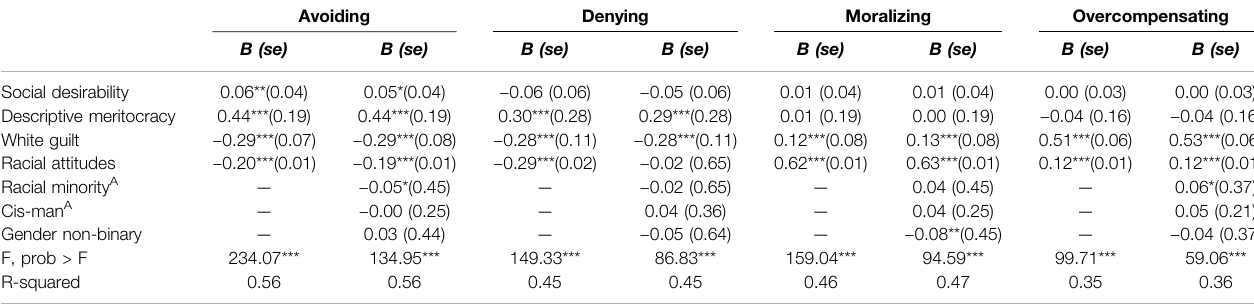
TABLE 5 | OLS regression results examining associations between PIE, criterion measures, race and gender in validation study. Avoiding Denying